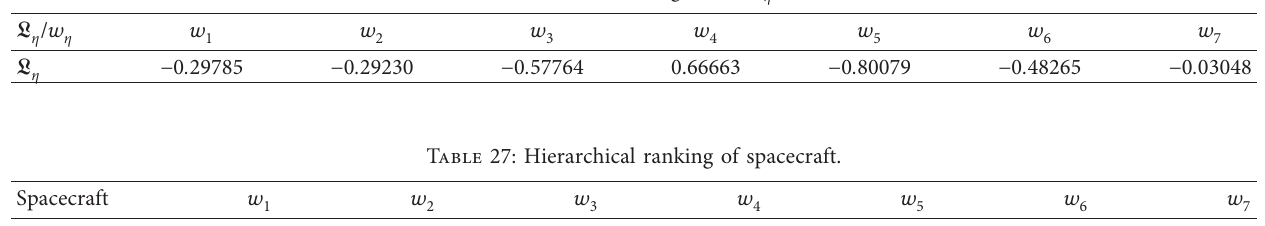
Table 26: Score degrees of 􏽥 E